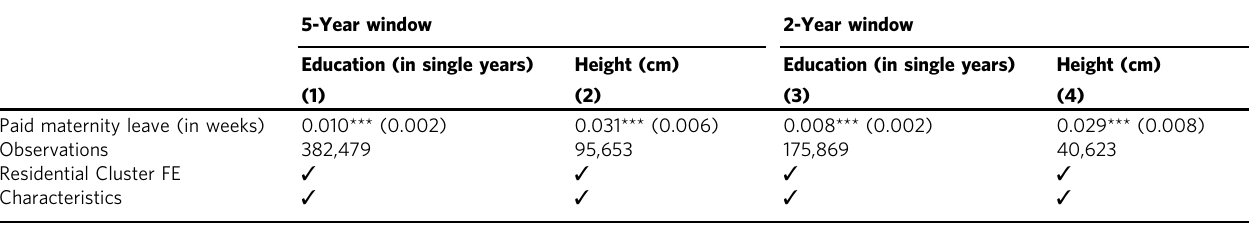
Table 4 The impacts of paid maternity leave — Robustness